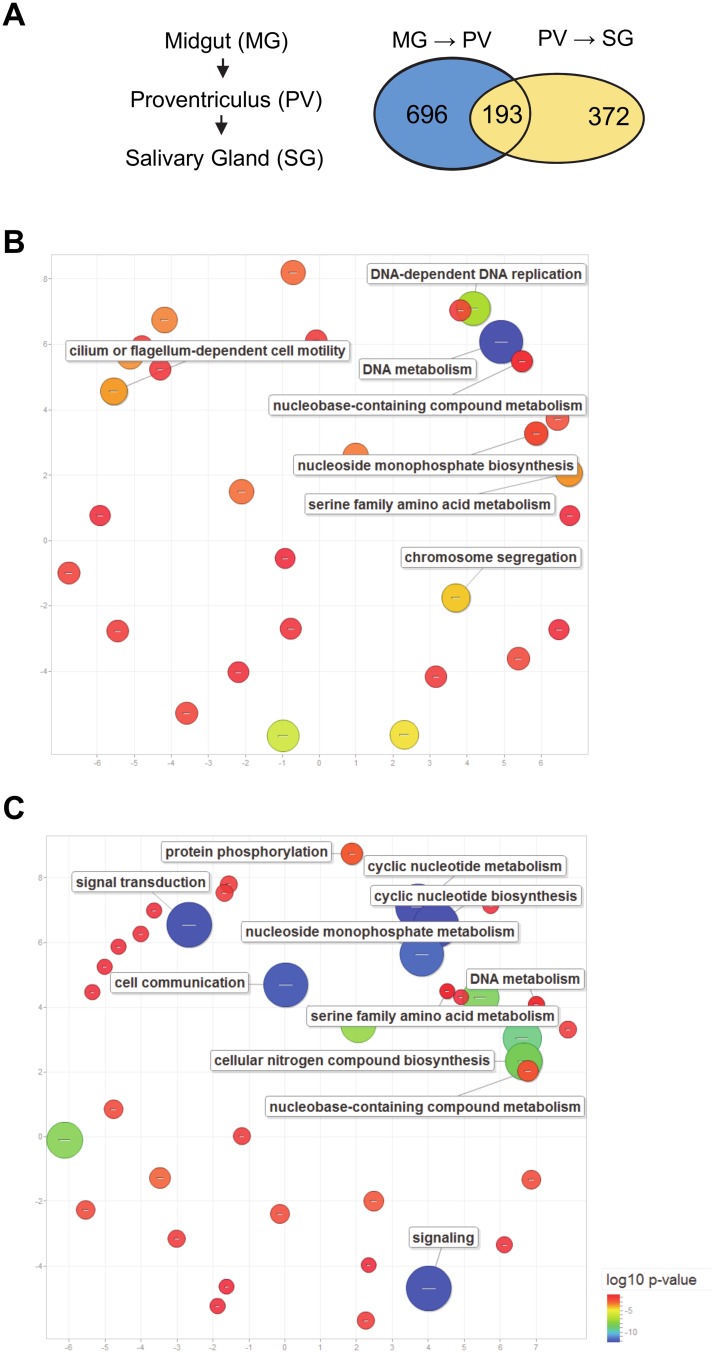
GO enrichment of differentially expressed genes between developmental stages.(A) A venn diagram of the number of unique and common differentially expressed transcripts between stages. (B) Scatterplot of enriched GO terms in up-regulated transcripts in the proventriculus. (C) Scatterplot of enriched GO terms in down-regulated transcripts in the salivary gland.